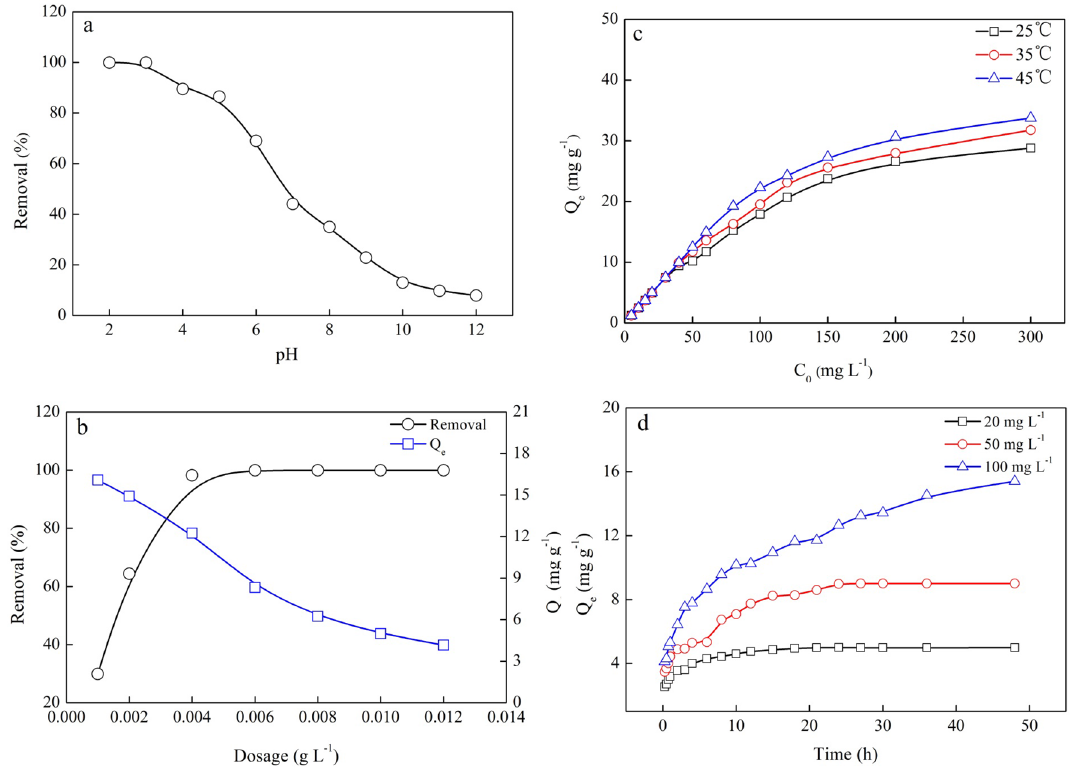
Figure 3. The effect of pH ( a ), dosage ( b ), initial concentration ( c ) and adsorption time ( d ) on the BMBC adsorption of Cr(VI). ( a ) [Concentration of Cr(VI) = 20 mg L −1 , dosage = 0.004 g L −1 , solution volume = 50 mL, adsorption time = 48 h, temperature = 25 °C ]. ( b ) [Concentration of Cr(VI) = 50 mg L −1 , solution volume = 50 mL, pH = 2.0, adsorption time = 48 h, temperature = 25 °C]. ( c ) [Dosage = 0.004 g L −1 , solution volume = 50 mL, pH = 2.0, adsorption time = 48 h, temperature = 25 °C]. ( d ) [Dosage = 0.004 g L −1 , solution volume = 50 mL, pH = 2.0, temperature = 25